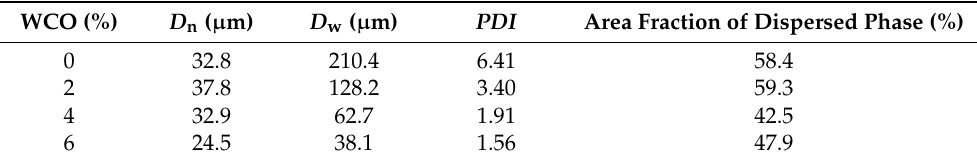
Table 4. Average diameters, dispersity and area fraction of dispersed phase of the unmodified and WCO-modified EAR